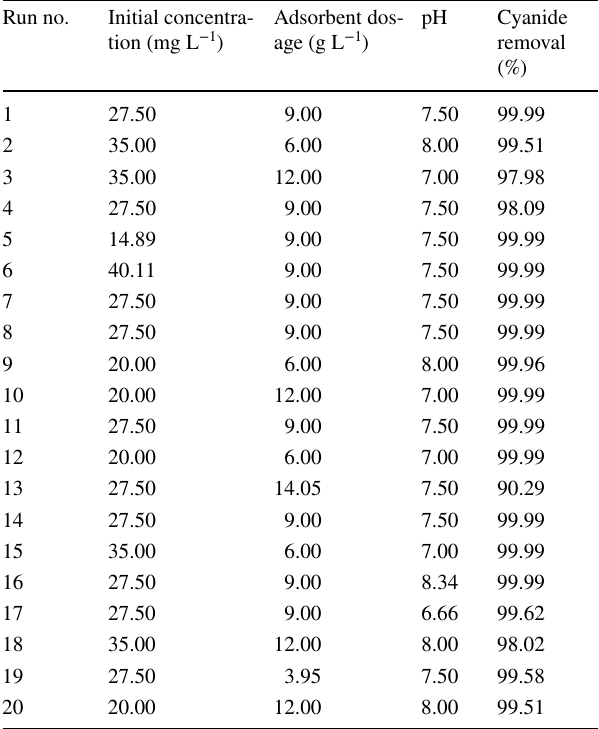
Table 7 Experimental design matrix for removal of cyanide using IIAC Run